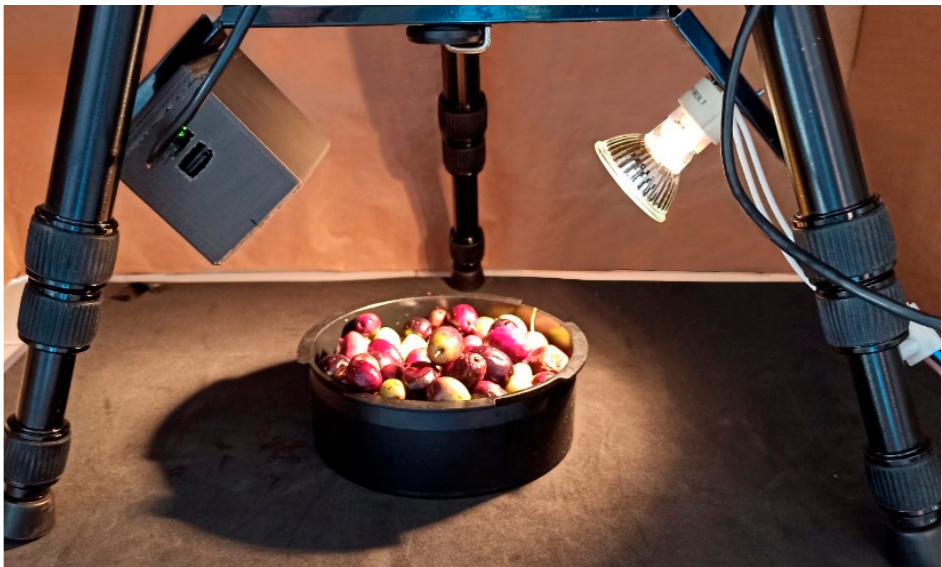
Figure 2. Example of an olive sample measurement taken during the spectral data acquisition. Four spectral captures were taken for each olive sample. Between captures, the olive samples were rotated 90 ◦ , being the average reflectance of the four spectra considered as representative data of each